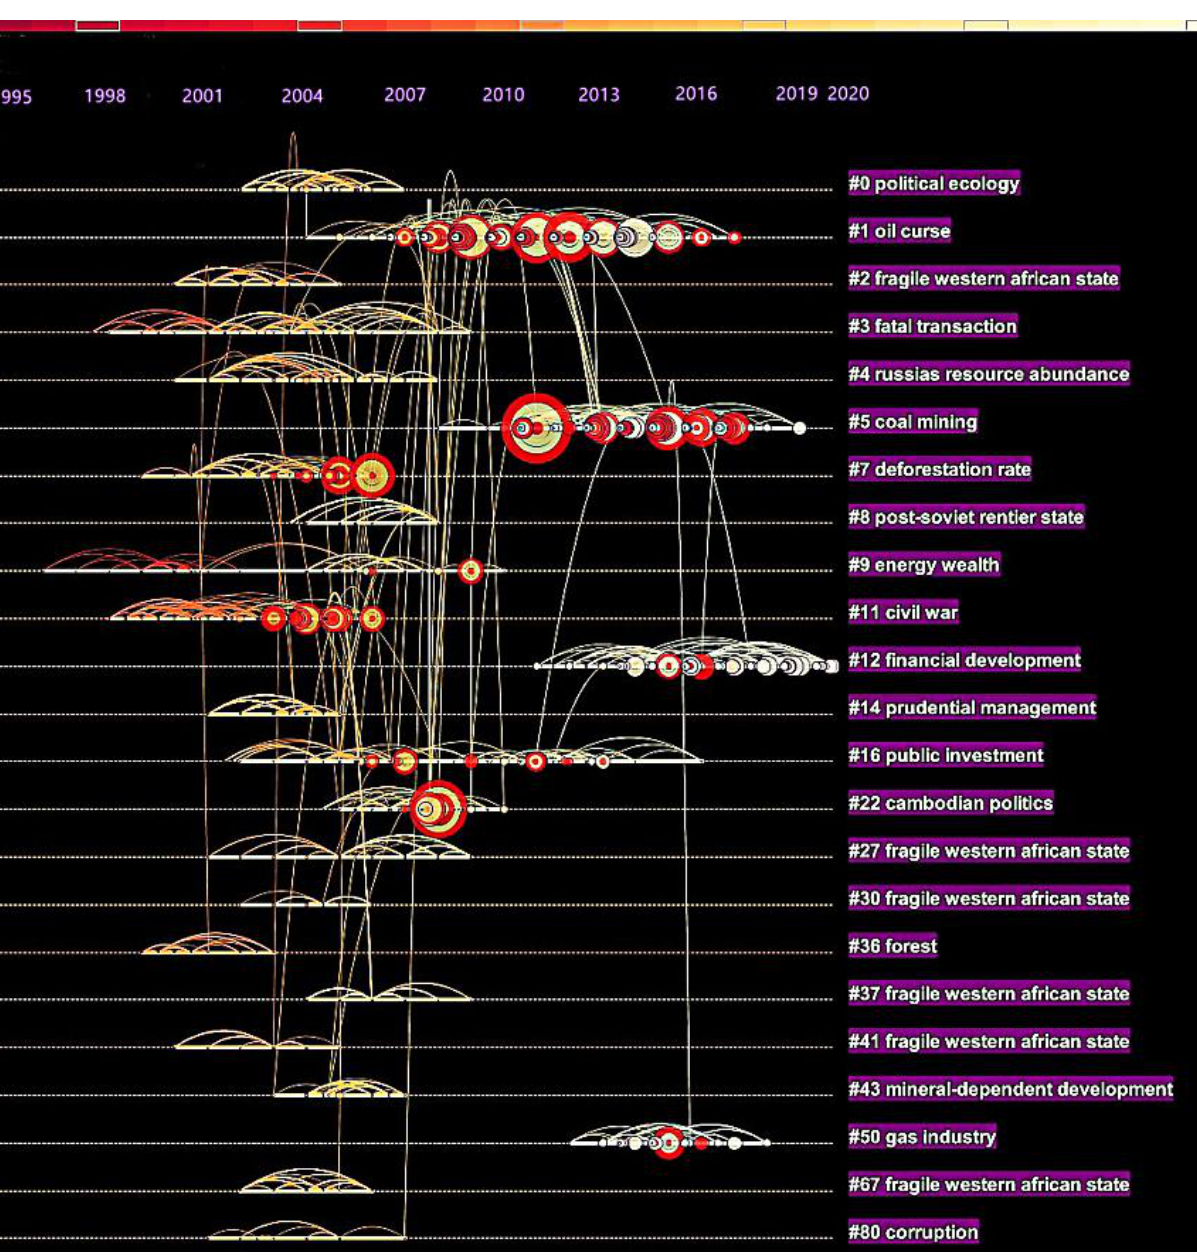
Figure 29. A timeline image of the reference co–citation framework during 1993–2020.